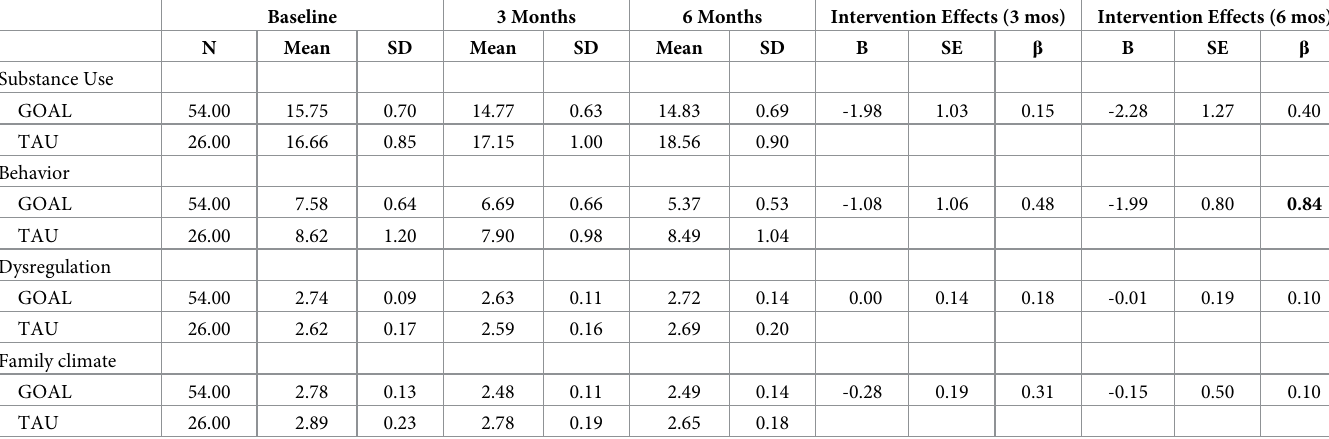
Table 1. Estimated means and outcome effects for GOAL and TAU at 3 and 6 months.